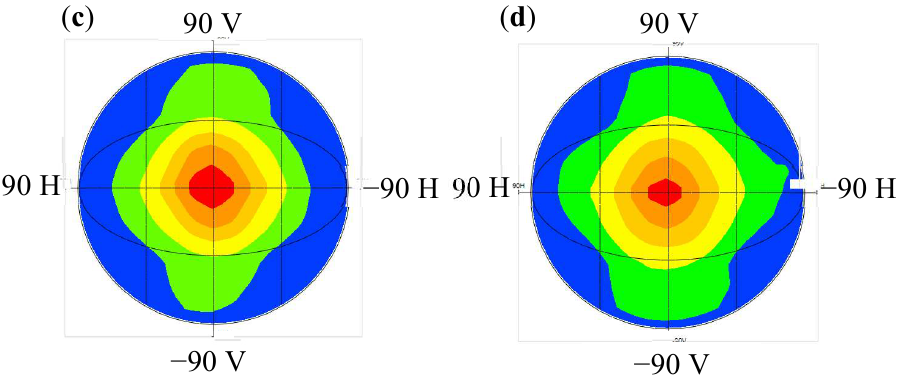
Figure 13. Simulation of an extra-thin, large-area, high-luminance surface light source backlight unit (BLU): ( a ) luminance distribution of a BLU without concave PSMLAs; ( b ) luminance distribu- tion of a BLU with concave PSMLAs; ( c ) light polar diagram of a BLU without concave PSMLAs; ( d ) light polar diagram of a BLU with concave PSMLAs.